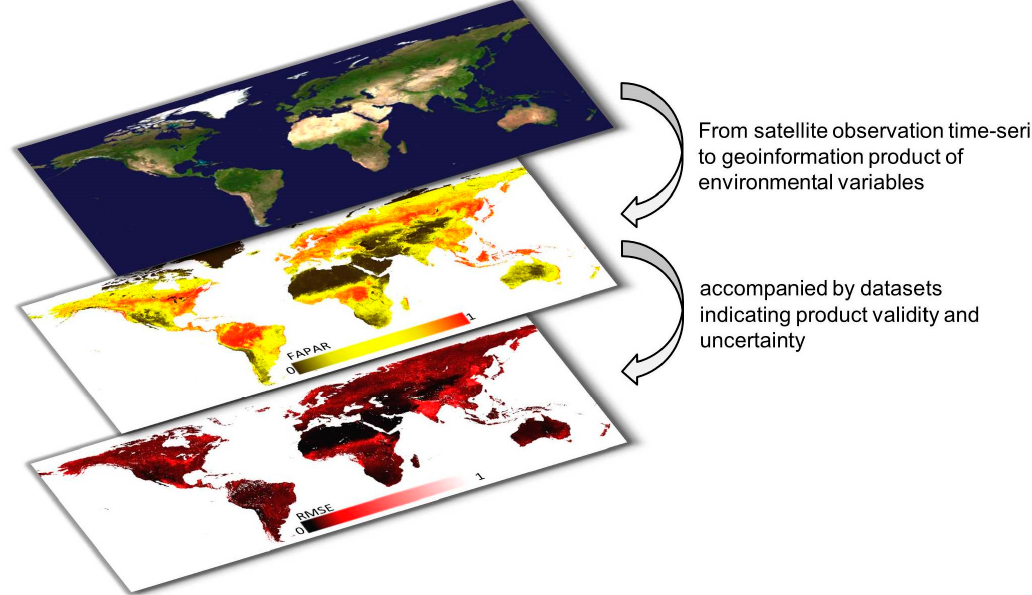
Figure 1. Physical earth (top) and global Satellite Pour l’Observation de la Terre Vegetation (SPOTVGT) fraction of absorbed photosynthetically active radiation (FAPAR) product (center [34,35]) with ancillary accuracy information (bottom, source [14]).